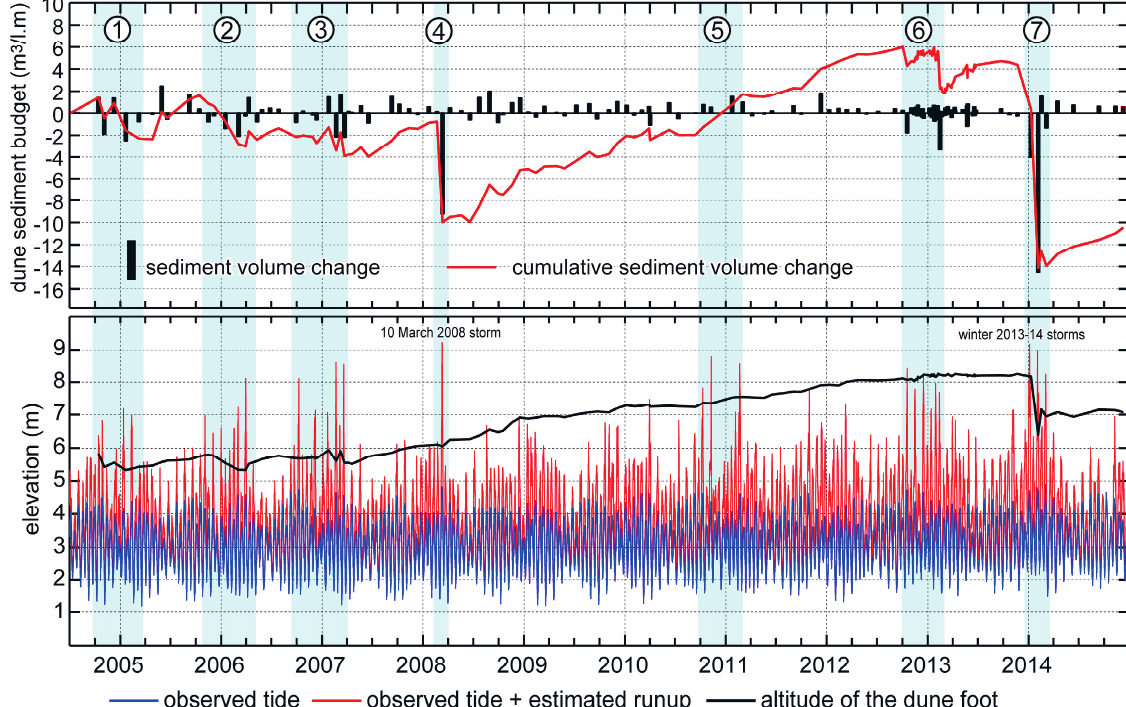
Figure 11. Evolution of the dune sedimentary budget related to extreme water levels over the period from July 2004 to December